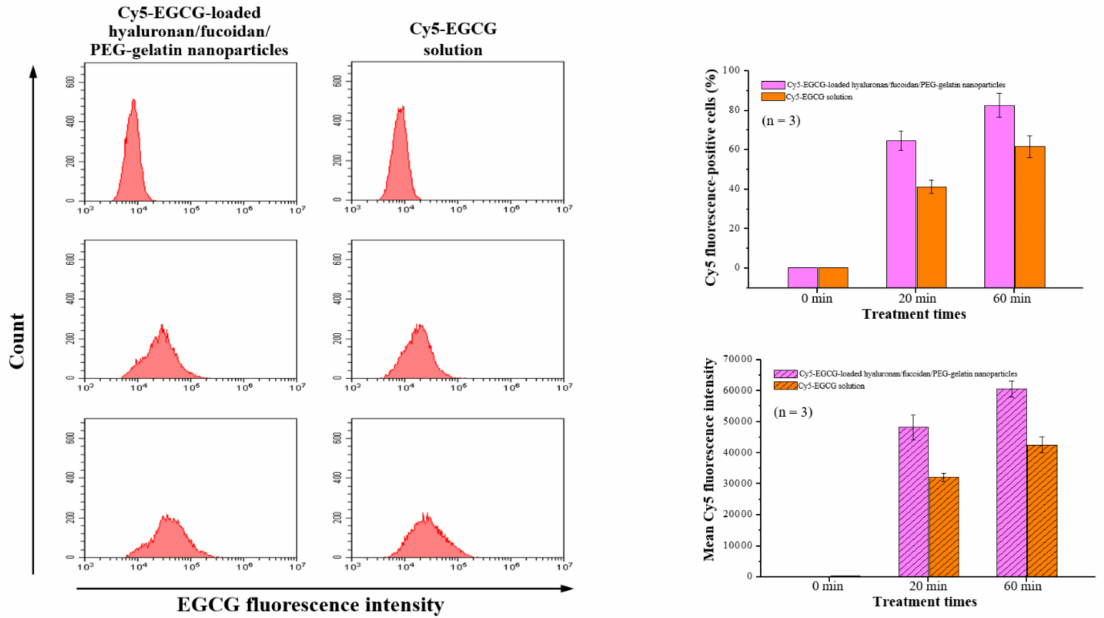
Figure 6. The cellular uptake and total fluorescence intensity of EGCG were examined using flow cytometry after treatment with Cy5-EGCG-loaded nanoparticles or Cy5-EGCG solution. Data are presented as means ± SDs ( n =